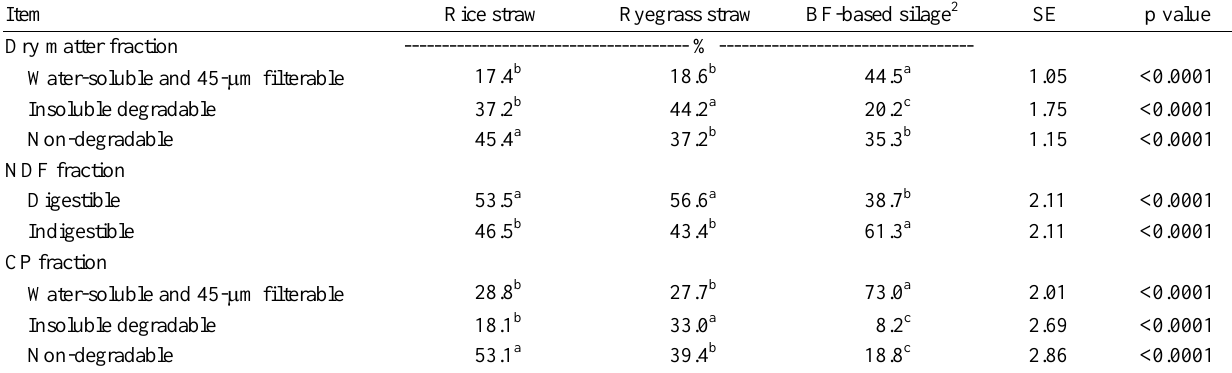
Table 4. In situ fraction of the DM, NDF and CP content of different feedstuffs 1